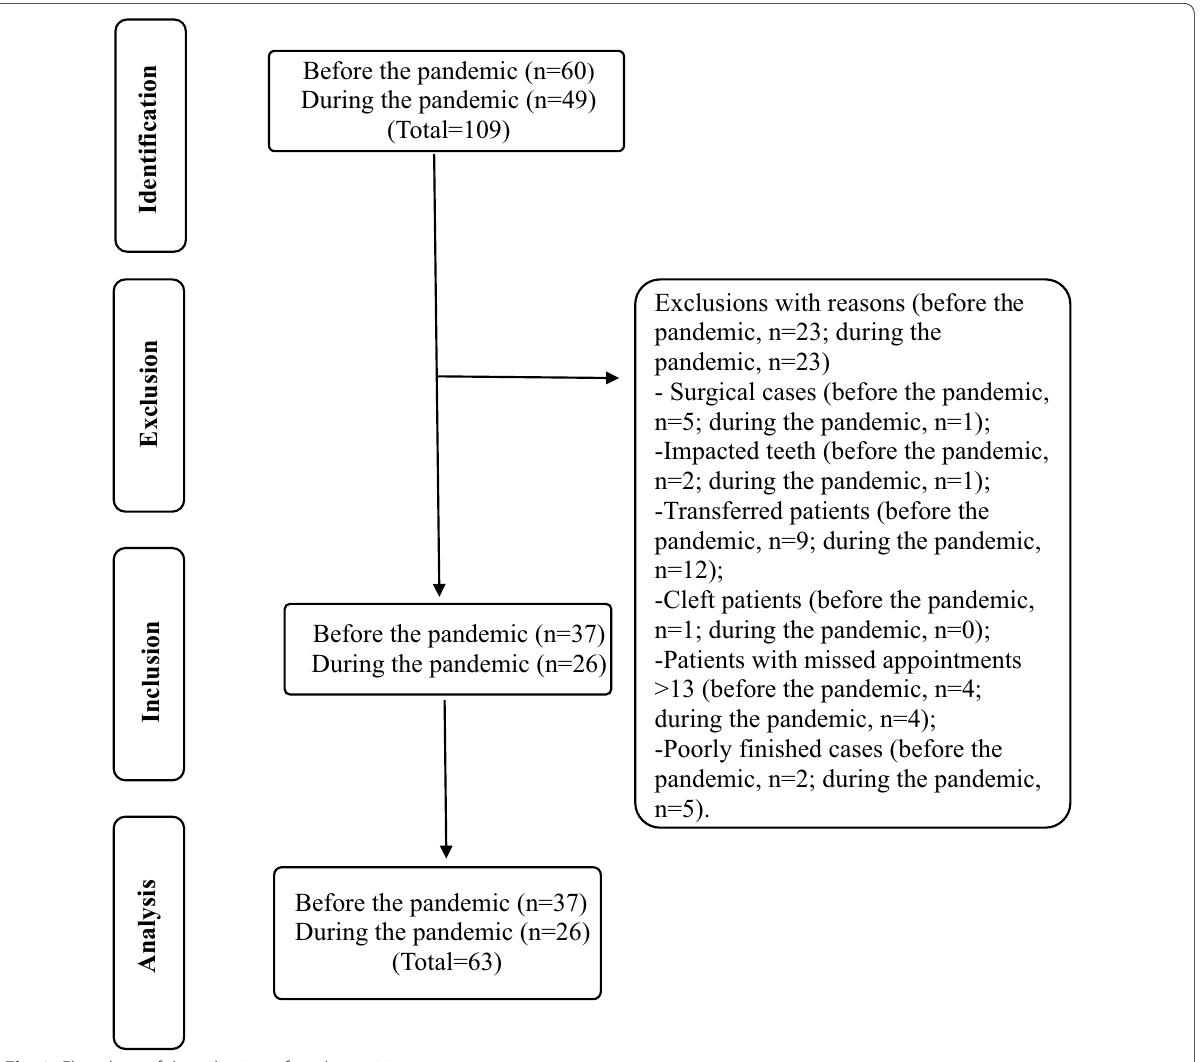
Fig. 2 Flowchart of the selection of study